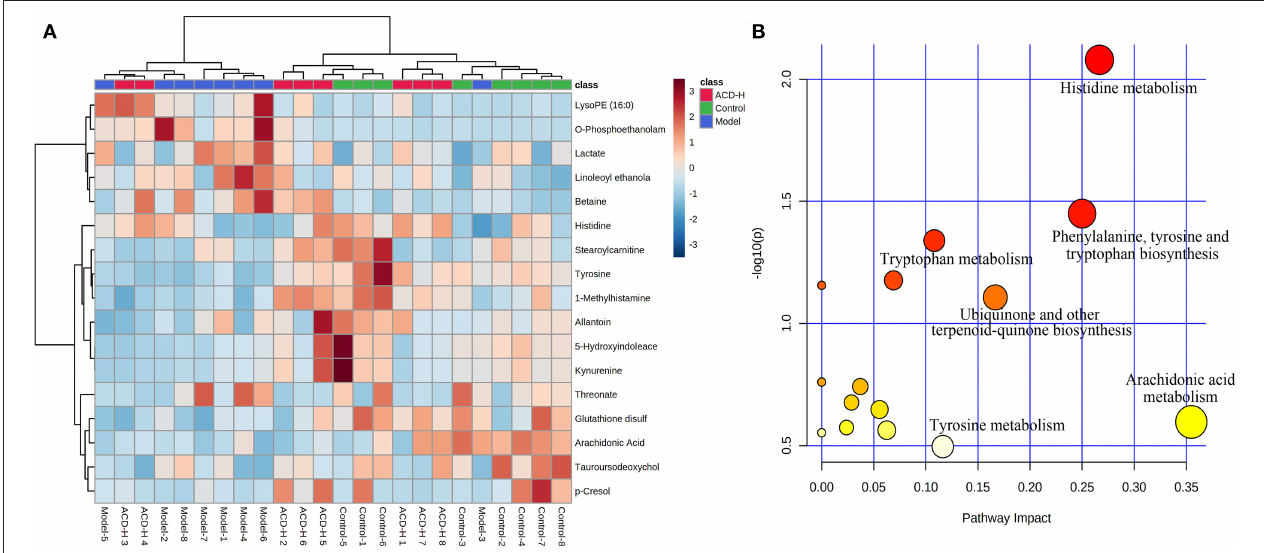
FIGURE 5 | Heatmap and pathway analysis of the potential liver metabolites. (A) Hierarchical clustering analysis of differential liver metabolites. The relative abundances of the metabolites are represented by different colors: red indicates high abundance and blue indicates low abundance. (B) Disturbed pathways in response to ACD treatment. The larger bubble size represents higher pathway enrichment, and the darker color represents higher pathway-impact